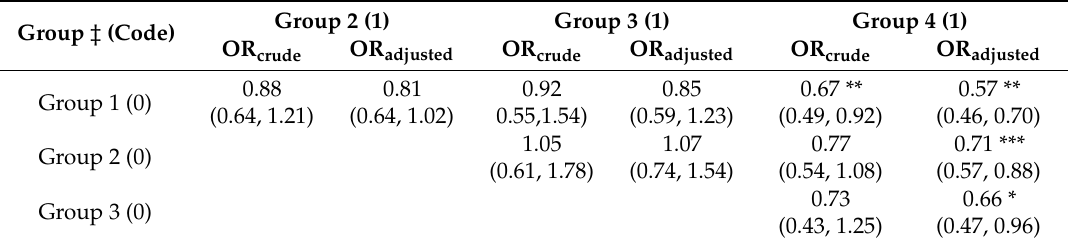
1: white children with private insurance; Group 2: white children with public insurance; Group 3: nonwhite children with private insurance; Group 4: nonwhite children with public insurance; in each group-based model, the group number was coded as 0 and 1; 0 was applied to the group with the